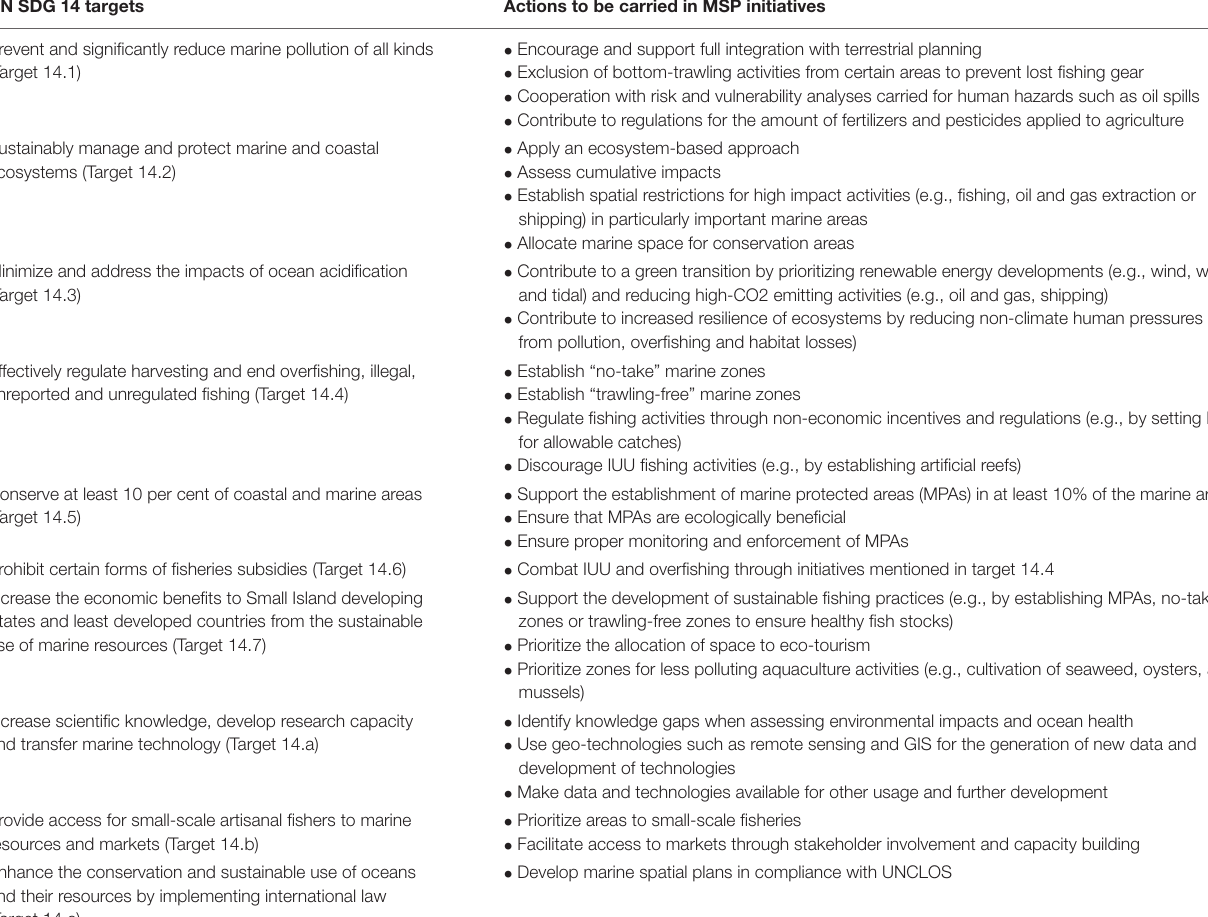
TABLE 1 | Potential contribution of MSP initiatives to meeting each of the 10 targets of the UN SDG 14 (see detailed information in section “Discussion and Conclusion”). UN SDG 14 targets Actions to be carried in MSP initiatives Prevent and significantly reduce marine pollution of all kinds (Target